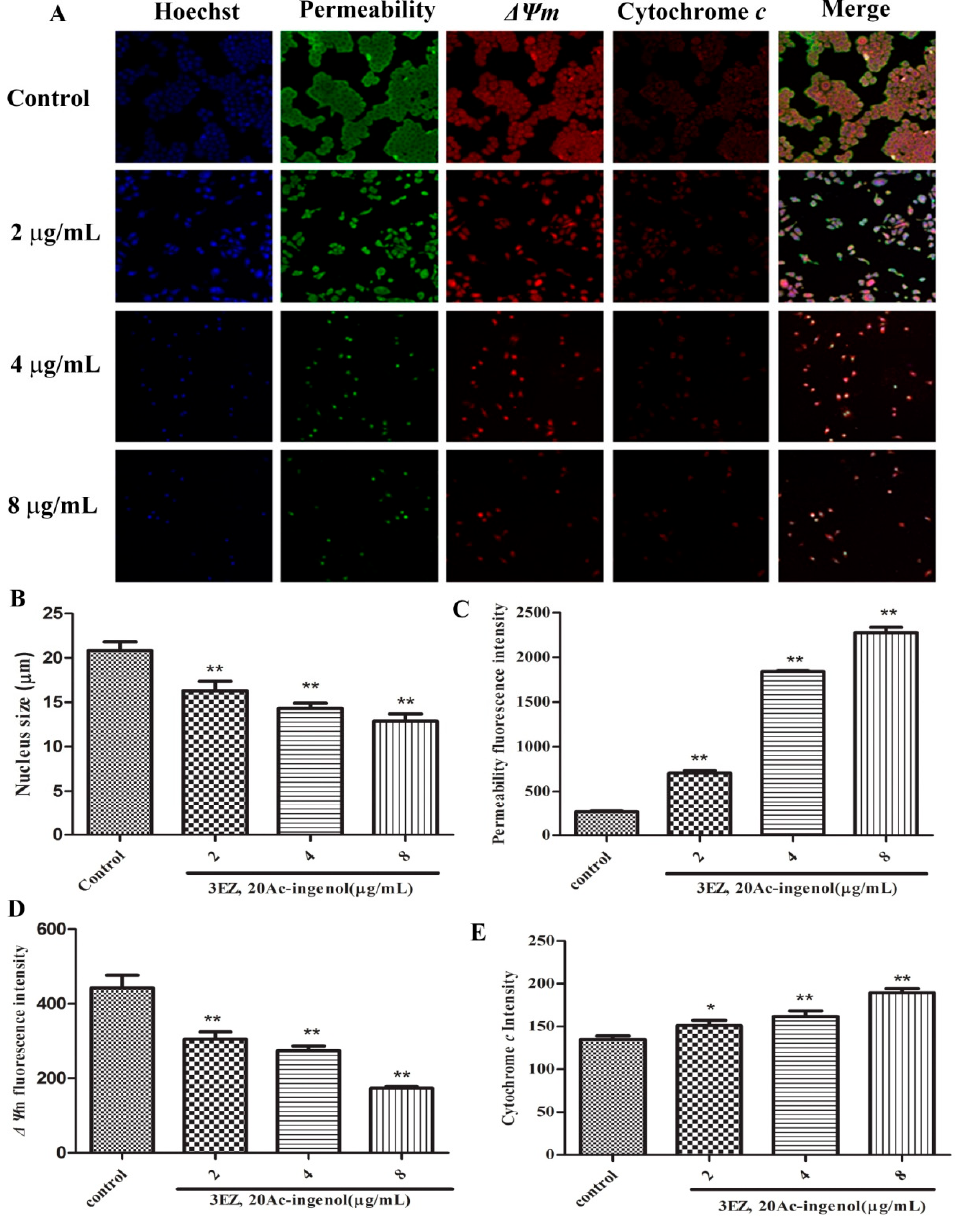
Figure 6. The mitochondrial function induced by 3EZ, 20Ac-ingenol in apoptotic hepatocyte L-O2 cells (×100). ( A ) Images of cells were taken by the high content screening (HCS) Assay Scan VTI Reader. ( B ) The average cell nuclear size was stained by Hoechst 33342 and quantified by the HCS Assay Scan software. ( C ) The cell membrane permeability was manifested by the average intensity of fluorescent dyes permeabilized through cell membranes. ( D ) The cell mitochondrial membrane potential ( ΔΨ m) was manifested by the average intensity of mitochondrial membrane potential fluorescent dyes. ( E ) The release of cytochrome c from mitochondria was manifested by the average cytochrome c intensity of fluorescent dye. Data are presented as mean ± SD from triplicate samples, * P < 0.05, ** P < 0.01 compared with control group.